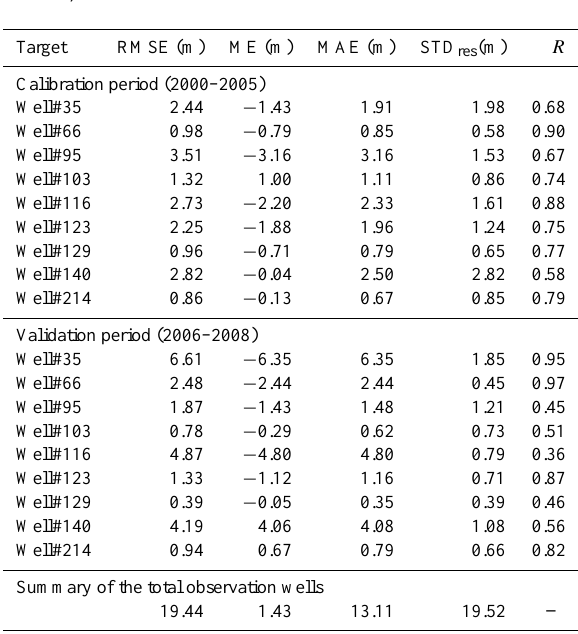
Table 7. Performance results of the calibration and validation pe- riod. The summary result of mean values comparison shown in Fig. 6 is also listed here. RMSE: root mean square error; ME: mean error; MAE: mean absolute error; STD res : standard deviation of residuals; and R : coefficient of correlation.